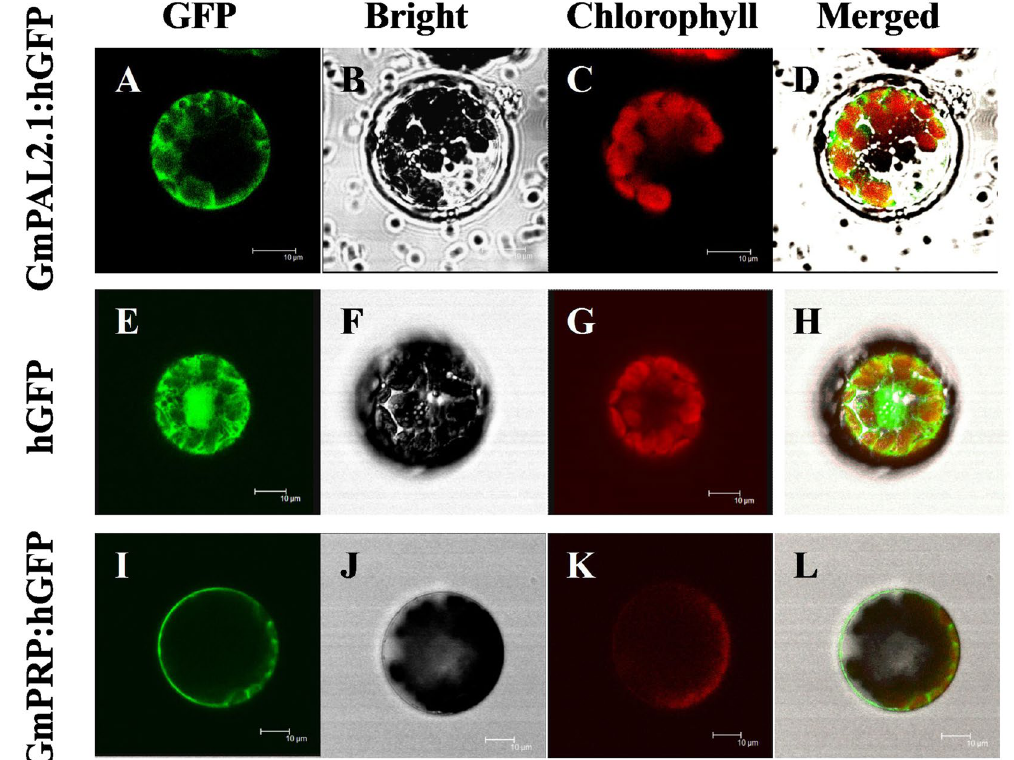
Figure 3. Subcellular localization analysis of the GmPAL2.1-GFP protein in Arabidopsis protoplasts. Subcellular localization was investigated in Arabidopsis protoplasts using a confocal microscope. The images of bright-field ( B , F and J ), the GFP fluorescence (green) only ( A , E and I ), the chlorophyll autofluorescence (red) only ( C , G and K ) and combined ones ( D , H and L ) are shown. All scale bars indicate 10 µ